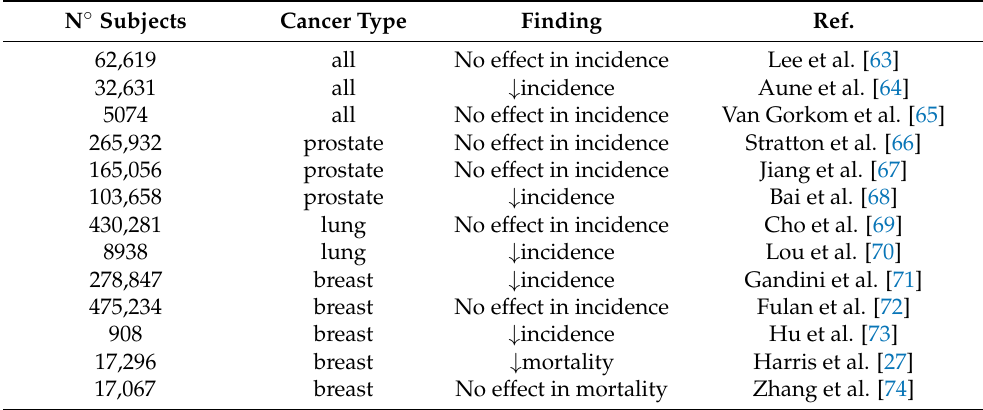
Table 2. Meta-analysis